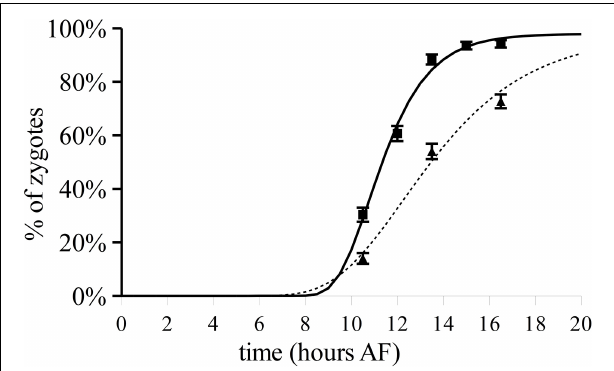
FIGURE 5 | Polarization after varying 180 ◦ reorientation over time and TBO staining in zygotes developing under unchanged unilateral light. Fraction of zygotes having a polarization vector that points toward the shaded side in relation to L1 (squares). Percentage of zygotes staining asymmetrically with TBO under unilateral light (triangles). Upper and lower error bars are standard deviations ( n = 300 in three replicate experiments). The lines depict the regressed Gompertz sigmoids that best describes the data (continuous, photopolarization according to L1; dotted, TBO patch staining).